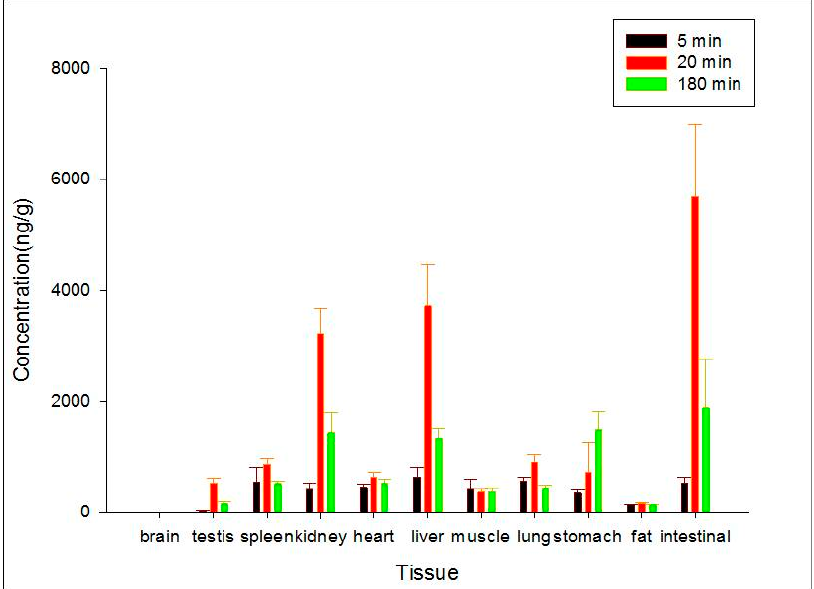
Figure 6. Concentration (mean ± SD) levels of ZGS1 in rat tissue at 5, 20, and 180 min after subcutaneous injection injection of ZGS1 (10 mg/kg) ( n = 5).